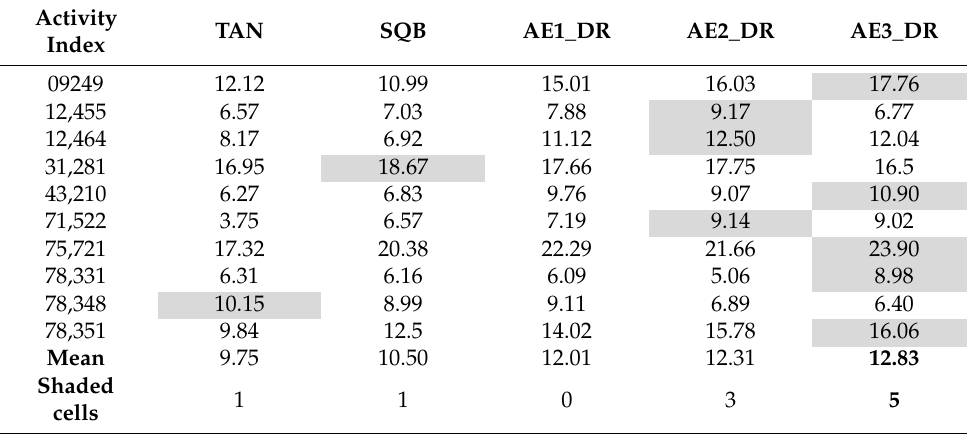
Table 8. The Retrieval results of top 1% for MDDR-DS3 dataset. Activity